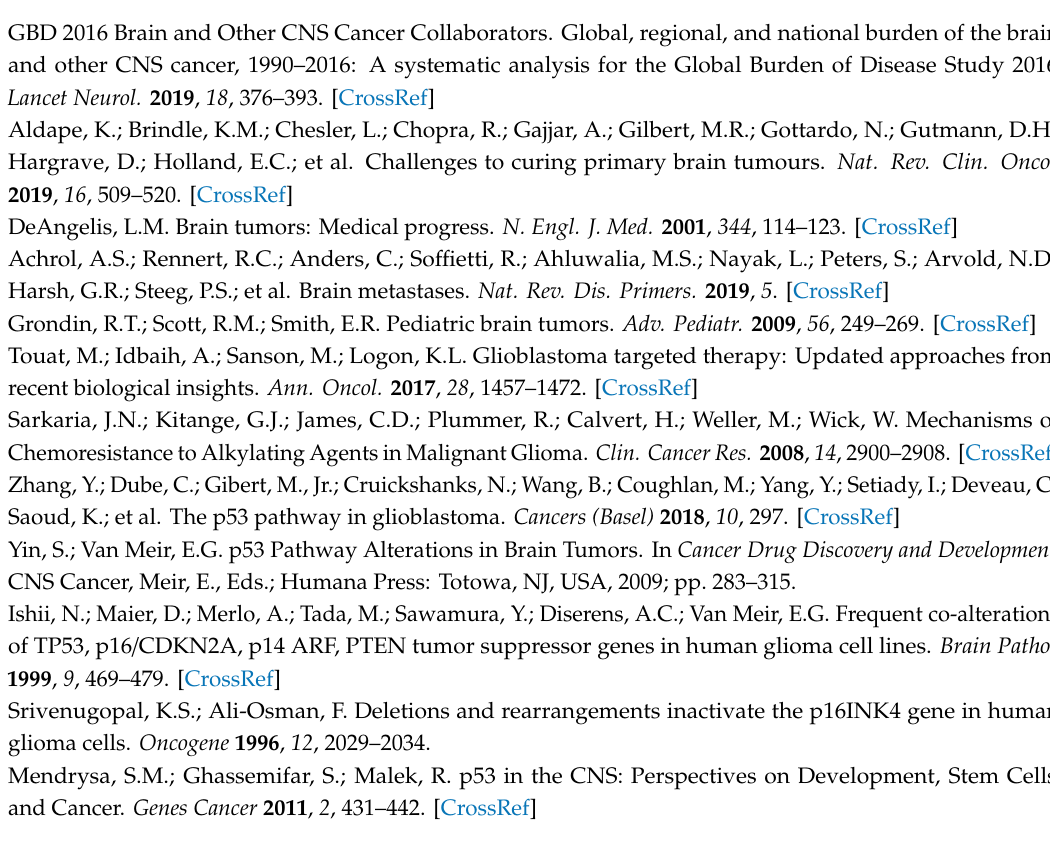
Table S1: p53 -status and MGMT proficiency of the brain tumor cell lines used in the